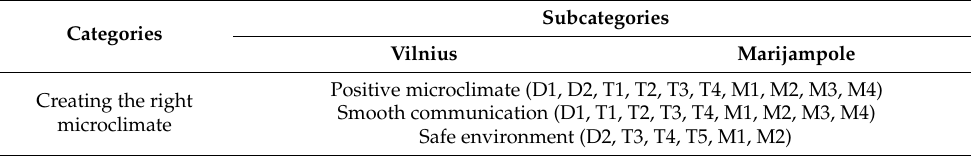
Table 6. The signs of a quality education institution and the roles of the manager.